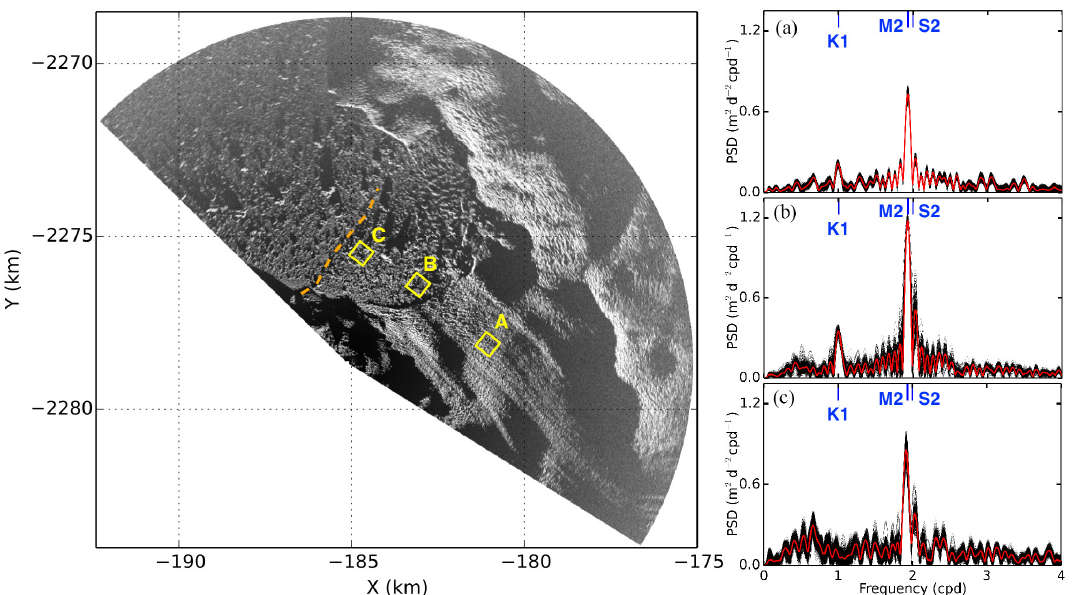
Figure 2. Stacked power spectral density (PSD) estimates of the LOS velocity time series for selected areas in 2016. Three 0.5km × 0.5km boxes ( a, b , and c ) mark the selected areas. PSD plots are normalized, and each black line represents 1 pixel (10m × 10m) in the correspond- ing box. Red line shows mean value. Blue lines mark frequencies of K1, M2, and S2 tide constituents. On map to the left, dashed orange line shows a significant step change of height in the mélange observed in 2016 (see also Fig.